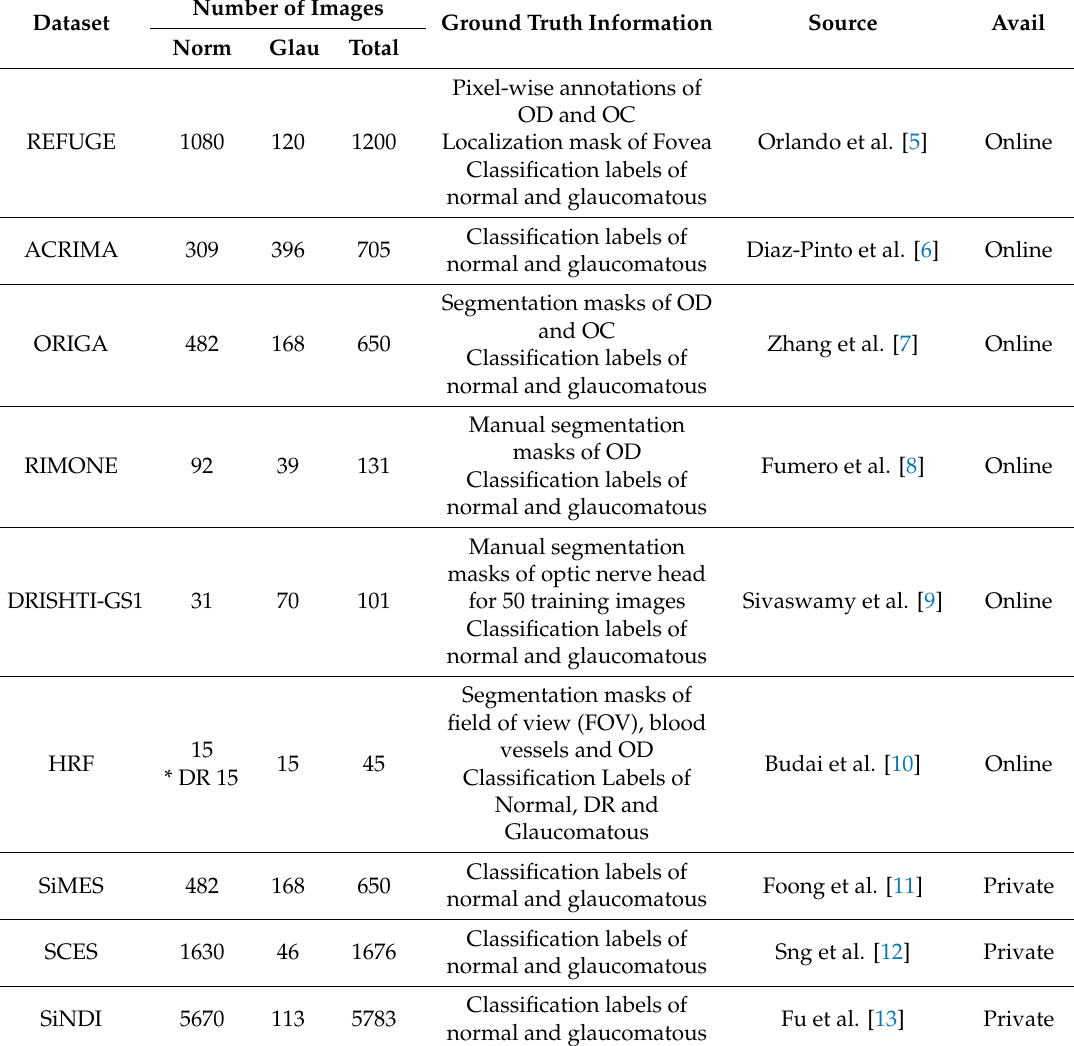
Table 1. Datasets for glaucoma